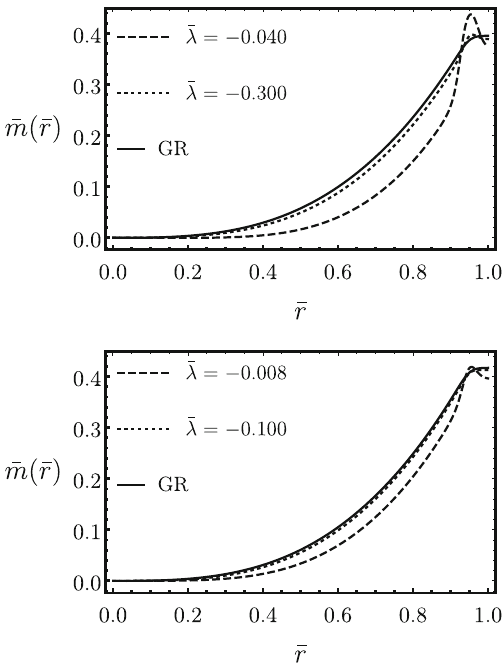
Fig. 8 Pressure as a function of r for different values of ¯ λ and ¯ ρ 0 = 0 . 110 (upper panel), and ¯ ρ 0 = 0 . 116 (lower panel)